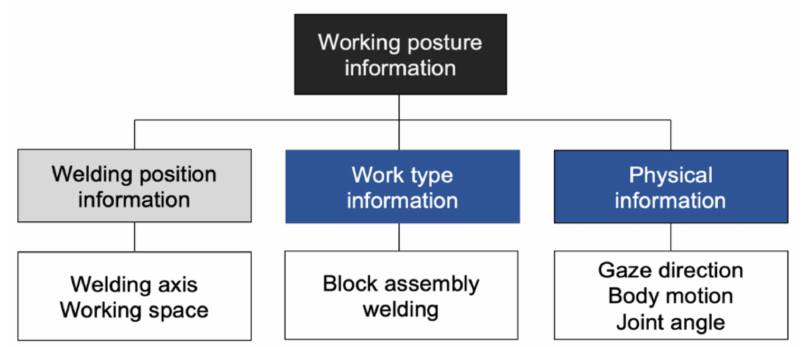
Figure 3. Structure of welding posture